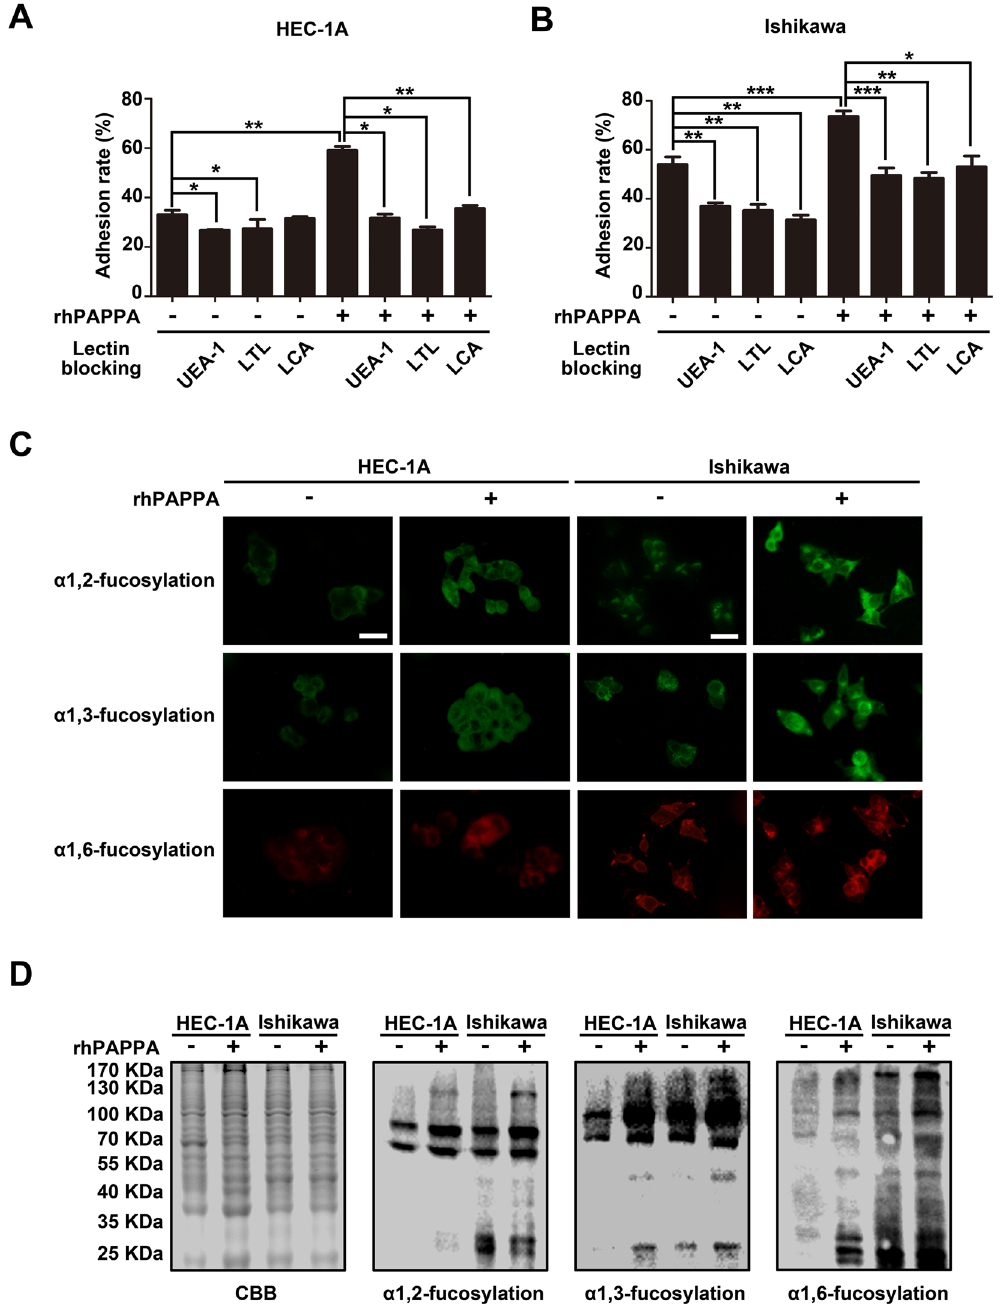
Figure 2. rhPAPPA promotes endometrial cell receptivity by increasing N-fucosylation. ( A,B ) UEA-1, LTL or LCA (5 μ g/ml) was incubated in control or rhPAPPA pre-treated HEC-1A and Ishikawa cells, and the adhesion rate was analyzed. ( C ) Lectin flourescent staining and ( D ) Lectin blotting detected the levels of α 1,2-, α 1,3- and α 1,6-fucosylation in HEC-1A and Ishikawa cells after rhPAPPA treatment. The bar represents 50 μ m. * p < 0.05, ** p < 0.01, *** p < 0.001. The data were presented as the means ± SEM of three independent